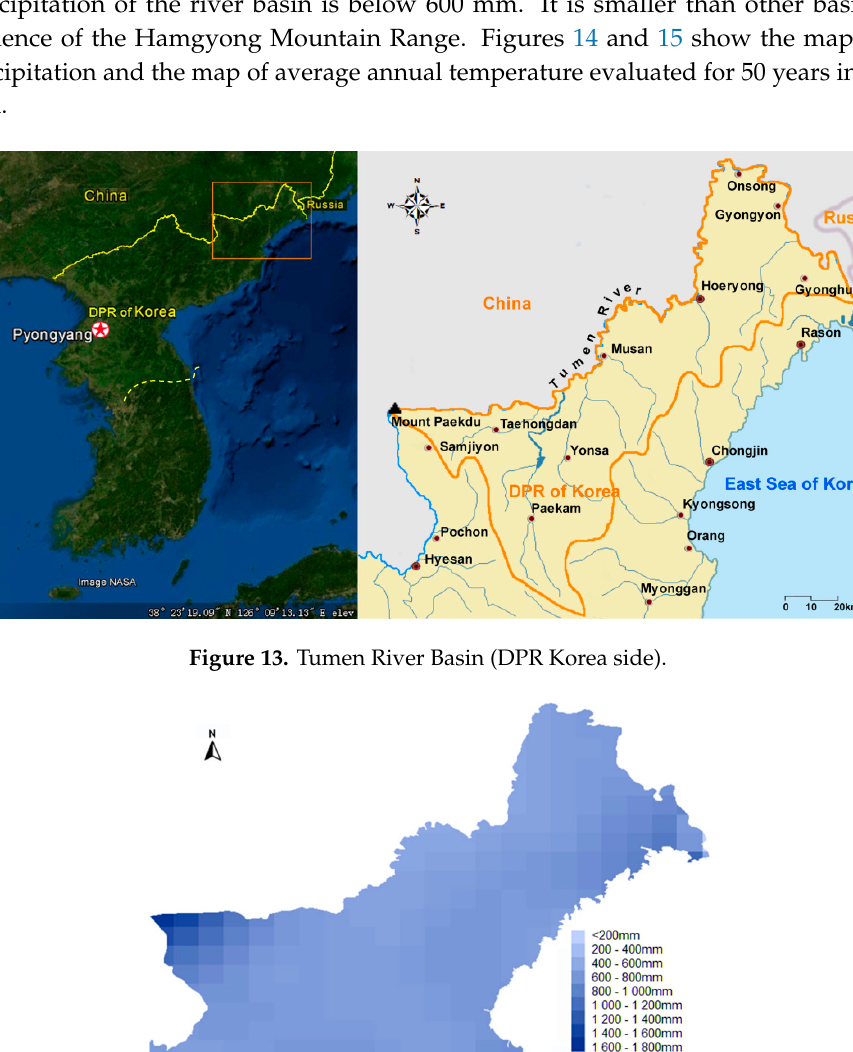
Figure 15. The map of average annual temperature evaluated for 50 years in the Tumen River Basin (DPR Korea side). 4.2. Water Resources of Tumen River Basin (DPR Korea Side) The proposed average annual runoff model was applied to the Tumen River Basin (DPR Korea side) for water resources computation. Figures 16 and 17 show the map of average annual evaporation and average annual runoff depth of the Tumen River Basin (DPR Korea side), respectively. The mean value of average annual precipitation, average annual evaporation, average annual runoff depth, average annual runoff, and total water resources of the Tumen River Basin are approximately 604 mm, 254 mm, 350 mm, 11 ⋅  2 /s km , and 3,707,829 × 3